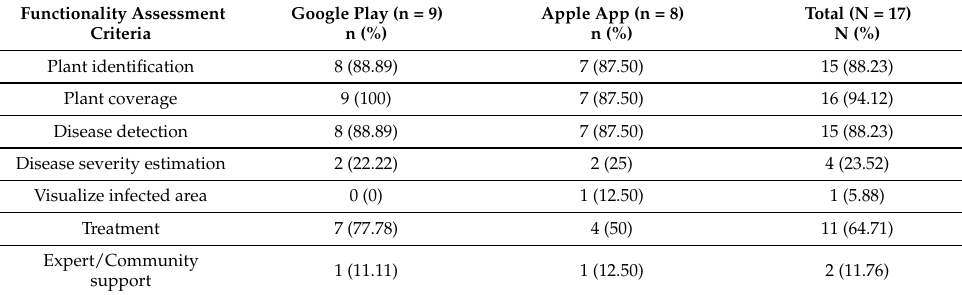
Table 5. Assessment criteria for the functionality of